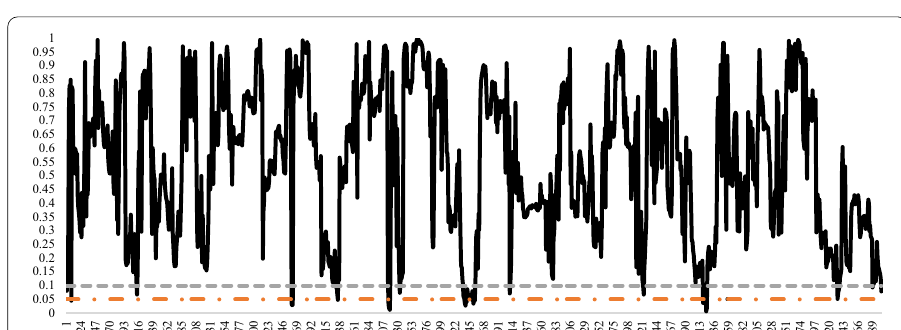
Fig. 8 The evolving p values of the AQ test statistic checked for Ethereum (ETH) in 50-day window length